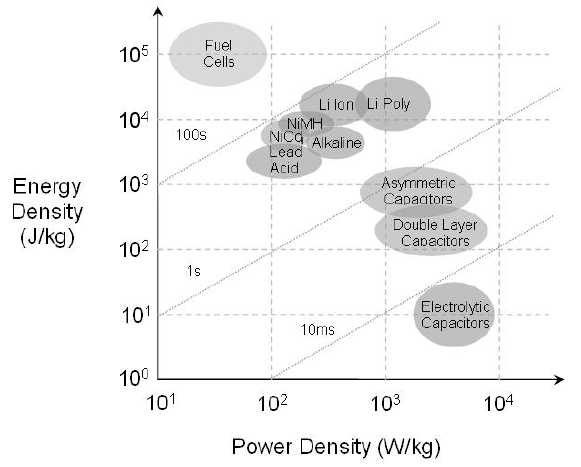
Figure 1. Ragone chart for capacitors, supercapacitors, batteries and fuel